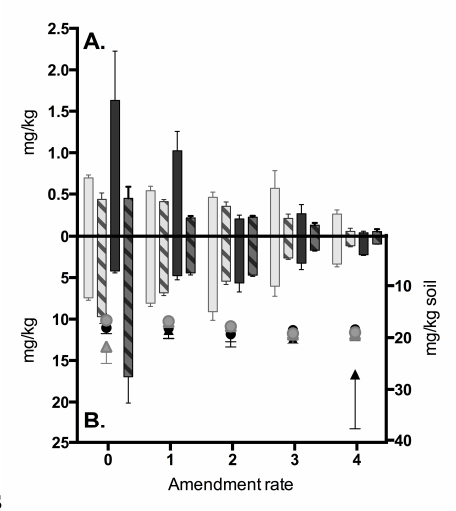
Figure 6. The nickel concentration of shoots ( A ) and roots ( B ) grown in Freeman (light grey) or Bernhill (dark grey) soils amended with KB- (solid) or wood- (cross- hatched) sourced biochars. The nickel of the soils (right axis, (B)) is also plotted for Freeman (light grey) or Bernhill (dark grey) soils amended with KB- (circle) or wood- (triangle) sourced biochars. Amendment rates are represented as 0–4, which correspond to rates of 0, 3, 6, 16, and 25% by volume for both biochars, 0%, 0.7%, 1.7%, 3.7%, and 8.6% by mass for wood biochar, and 0%, 0.4%, 1.2%, 2.5%, and 5.8% by mass for KB-sourced